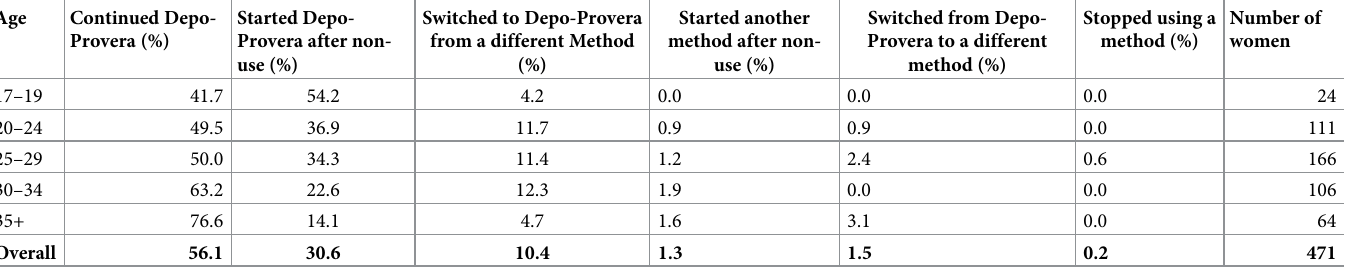
Table 2. Method continuation and switching at visit percent distribution of the change in contraceptive use as a result of the clinic visit, by age group, Tanzania 2018. Age Continued Depo- Provera